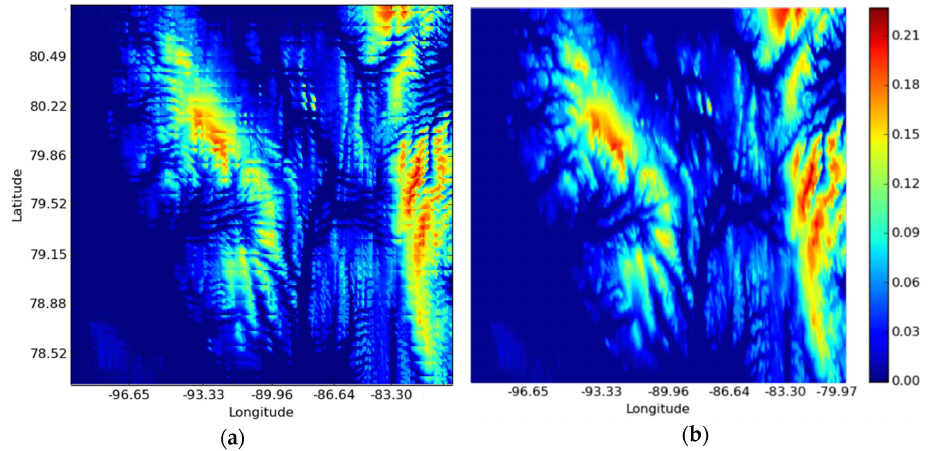
Figure 16. ( a ) Difference between terrain-corrected and ellipsoid longitudes in the original scan order (from VIIRS Moderate Bands SDR Terrain Corrected Geolocation (GMTCO) and Original (elliptical) Geolocation (GMODO) files); ( b ) De-bowtized difference after